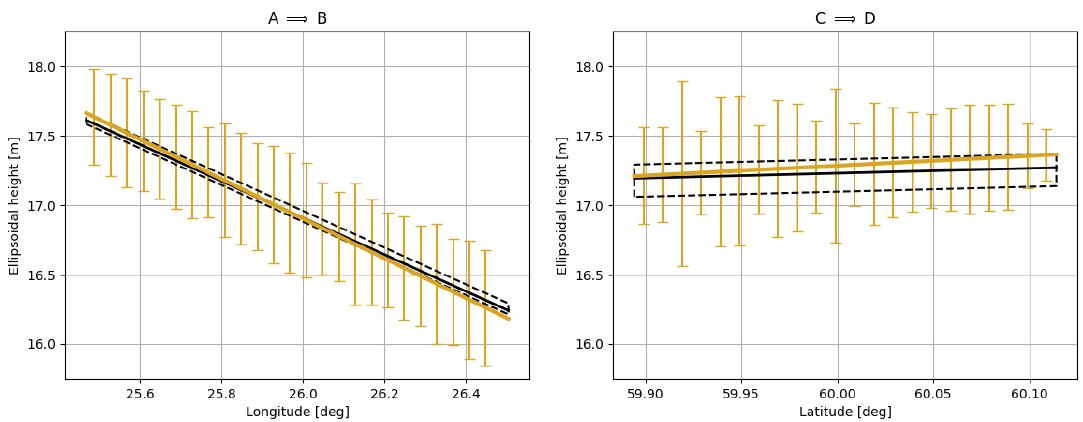
Figure 10. ( Left ) Linear fit of SSH data results from the first group (AB/BA) as a function of longitude component from their location (gold color). The error bars indicate ± σ intervals along the fitted track. The corresponding results of SSH ref are also plotted (black), where the dashed lines indicate the range of values of SSH ref along the track (instead of ± σ intervals). ( Right ) The equivalent result of the second group (CD/DC) as a function of